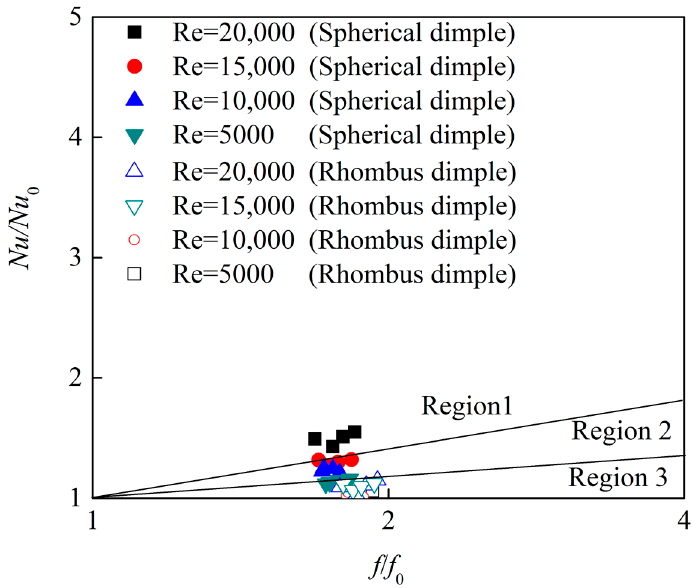
Figure 20. Performance evaluation plot of different dimpled channel.